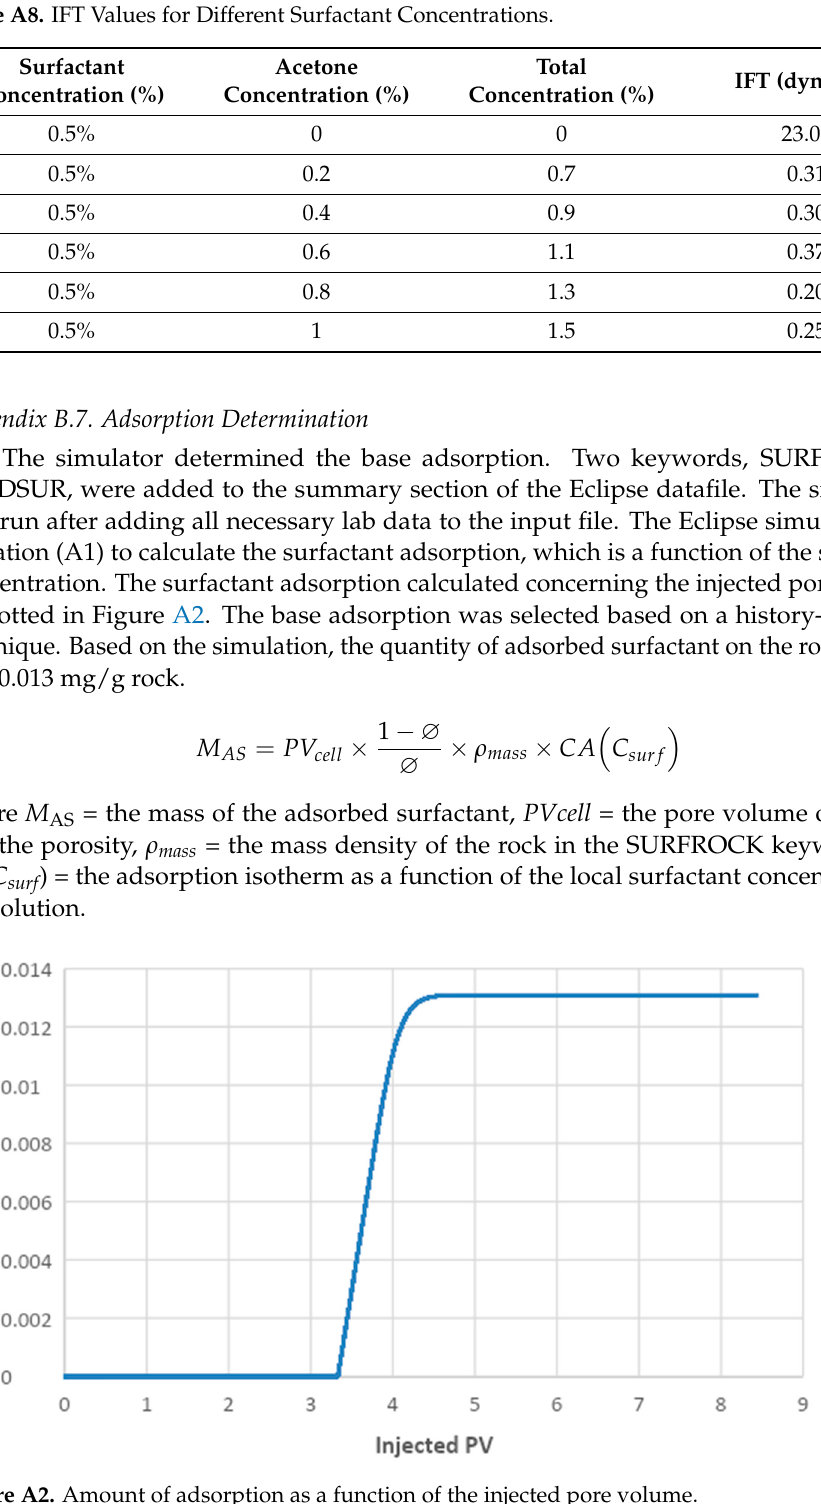
Figure A2. Amount of adsorption as a function of the injected pore volume.